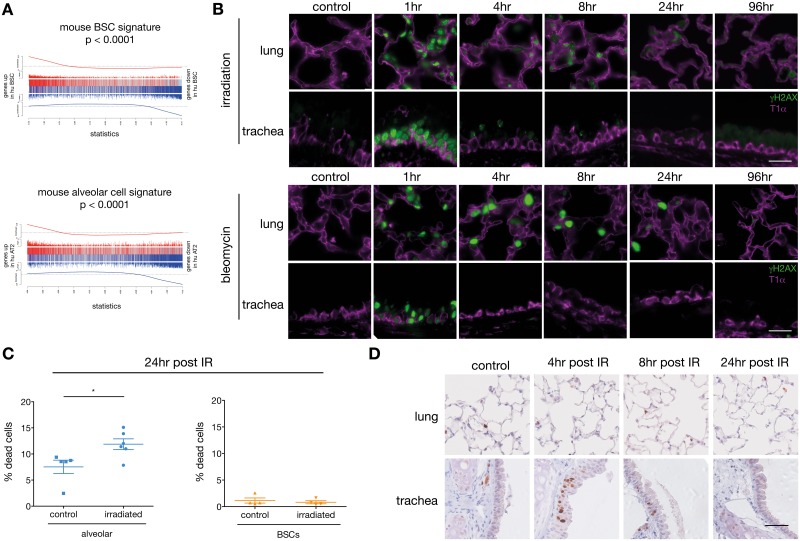
Mouse tracheal BSCs are less sensitive than alveolar cells to DNA damage-induced cell death.(A) Barcode plots showing strong correlation of mouse and human expression signatures. The upper panel correlates the mouse tracheal BSC signature with that of human lung BSCs; the lower panel correlates the mouse alveolar cell signature with that of human AT2 cells. For each plot, genes are ordered left to right from most up-regulated to most down-regulated in human BSCs or AT2 cells, relative to all other cell populations. Positive mouse signature genes are marked with red vertical bars, and negative mouse signature genes with blue. Variable-height vertical bars show log-fold changes for the mouse signature genes. Worms show relative enrichment of mouse genes in the human ranked list. Rotation gene set tests give p = 0.0001 for each plot. (B) Immunofluorescence staining of γH2AX and T1α in alveoli or trachea of wild-type (WT) mice that are either nonirradiated or 1, 4, 8, 24, or 96 h post irradiation (6 Gy, top panel) or saline injected or 1, 4, 8, 24 or 96 h post bleomycin injection (40 mg/kg intravenously, bottom panel). T1α marks alveolar type 1 cells in the lung and BSCs in the trachea. Representative images of n = 3 mice at each time point. Scale bar = 20 μm. (C) FACS detection of dead cells in lung alveolar (EpCAM+) or tracheal BSCs (T1α+) isolated from WT mice 24 h post irradiation (6 Gy). n = 4–6 mice per group. Student’s t test. (D) Immunohistochemistry staining of Ki67 in alveoli or trachea of WT mice control or 4 h, 8 h, or 24 h post irradiation (6 Gy). Representative images for one of n = 3 mice at each time point. Scale bar = 20 μm. The underlying data for panel C can be found in the S1 Data file.